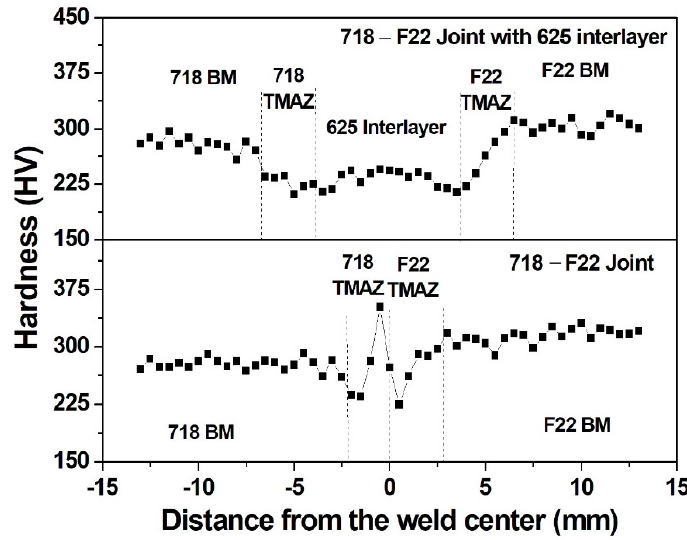
Figure 7. The hardness distribution across the weld interface of the 718-F22 friction weld joint with and without 625 interlayer. and without 625